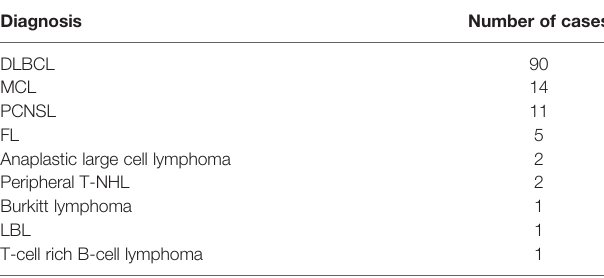
TABLE 1 | Diagnostic distribution of 127 non-Hodgkin lymphoma patients who underwent diagnostic lumbar puncture according to the routine clinical practice and were negative for leptomeningeal involvement.